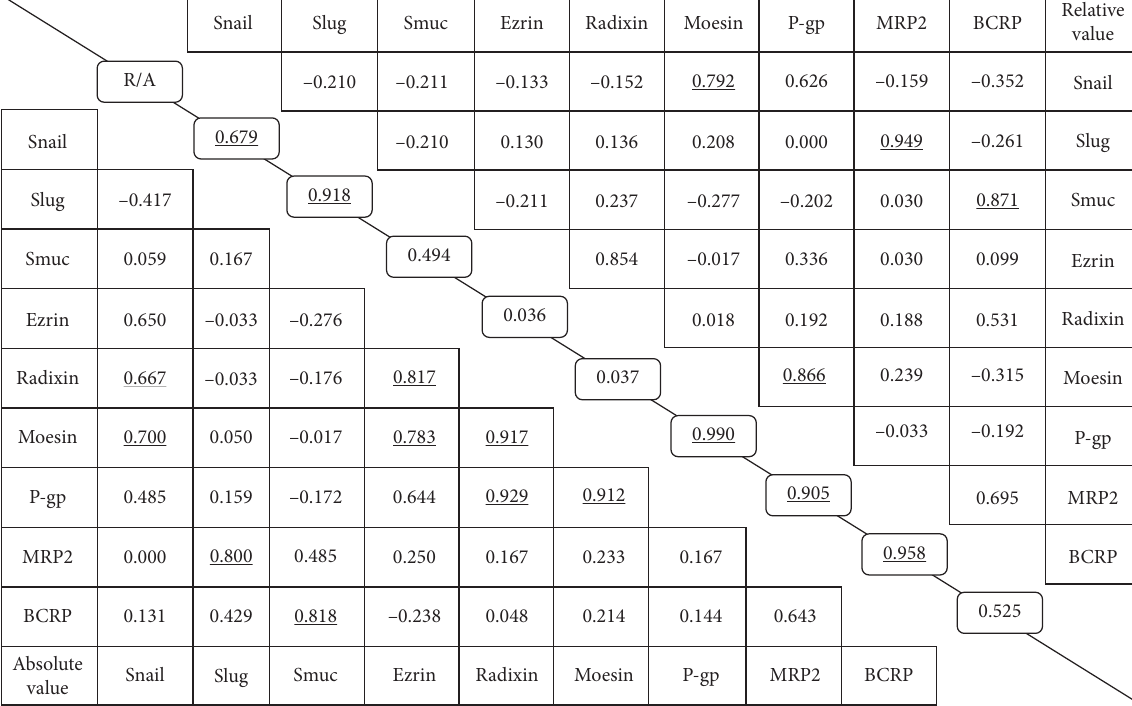
Figure 1: Correlations ( r values) among absolute and relative mRNA expression levels of SNAI family members, ERM proteins, and efflux transporters in clinical lung cancer tissue samples. Each value in the part below the oblique line shows the correlation of the absolute values of the parameters in the corresponding row and column, and those in the part above the oblique line show the correlation of the relative values of the parameters in the corresponding row and column. The values on the oblique line show the correlation between relative and absolute values (R/A) of the same parameter. The boldface underline indicates p < 0.05 .